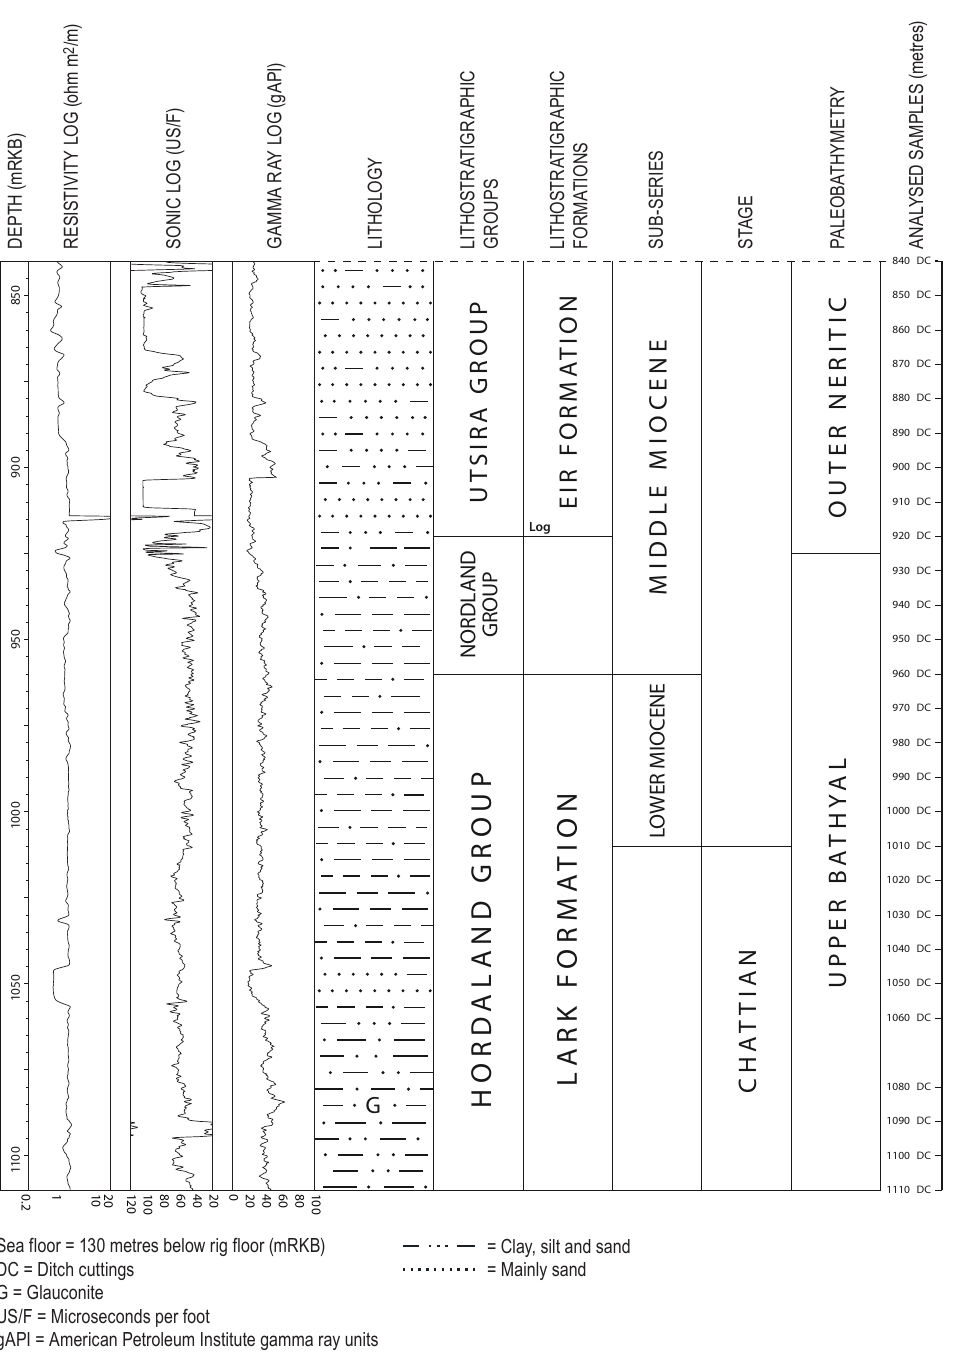
Figure 54. Well summary figure including resistivity log, sonic log, gamma-ray log, lithology, lithostratigraphic units, sub-series, stage, paleobathymetry and analysed samples for the lower part of the investigated sequence in well 30/6–3 (Chattian to middle Miocene; modified after Eidvin et al.,